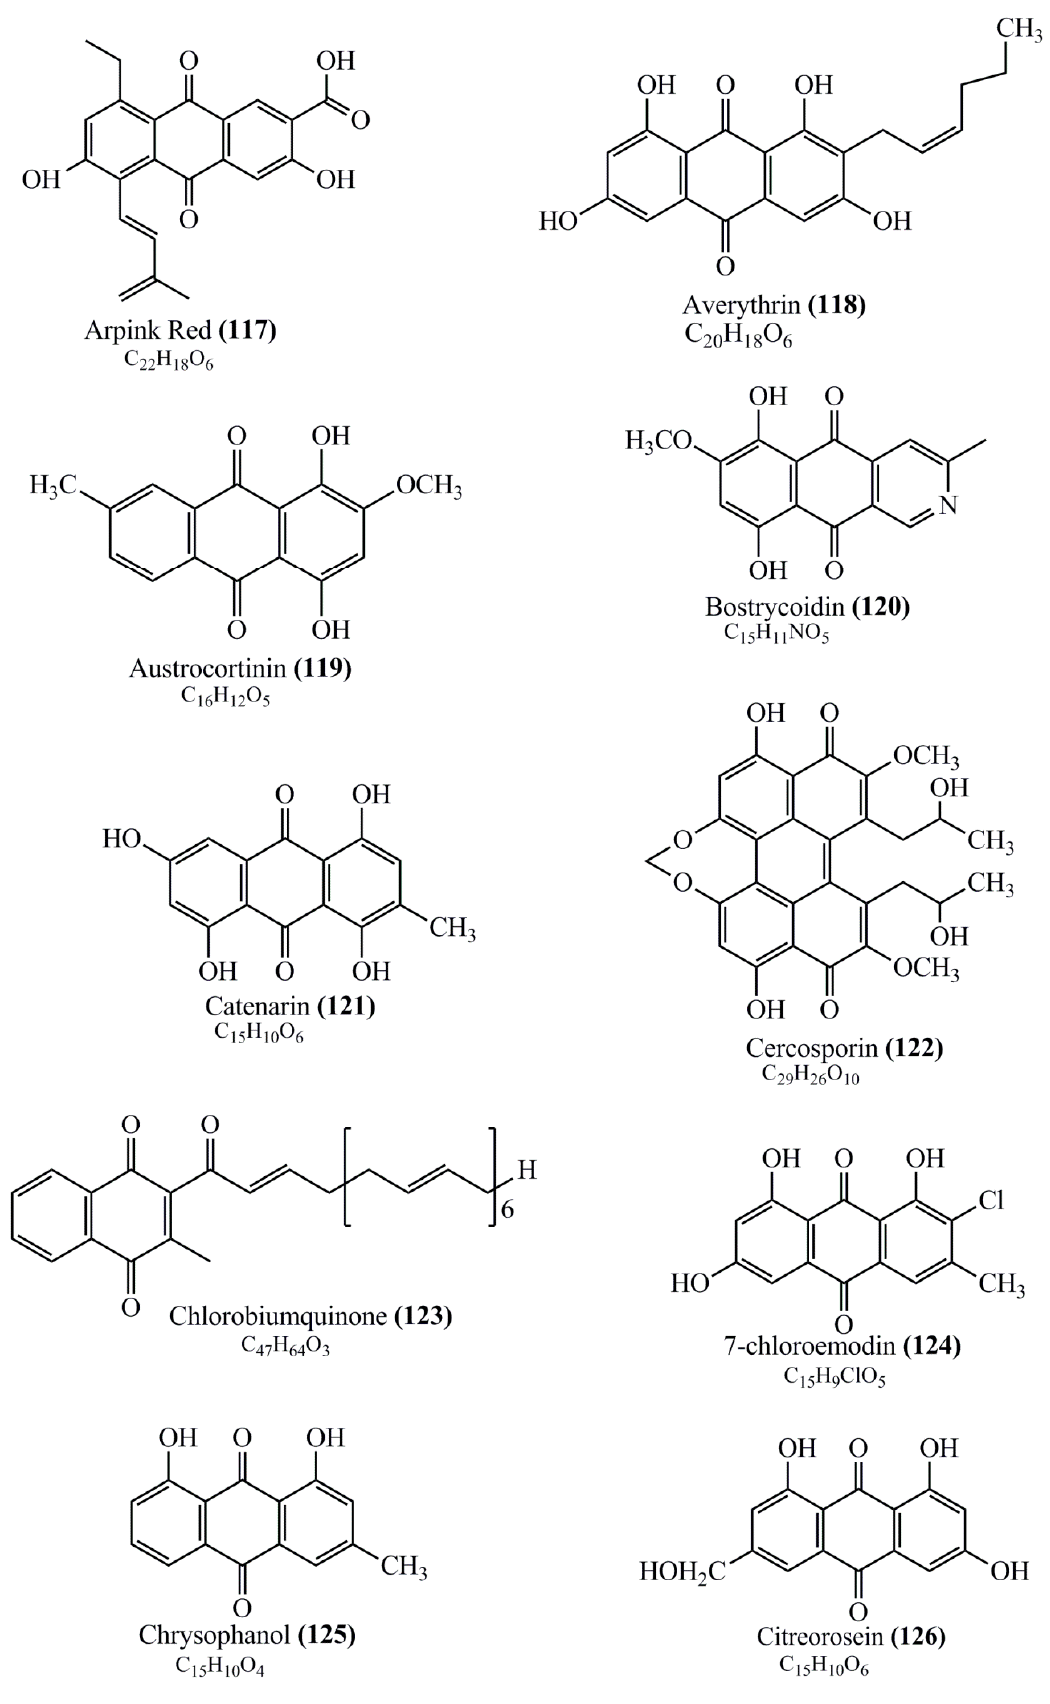
Figure 1. Continued. Figure 1.